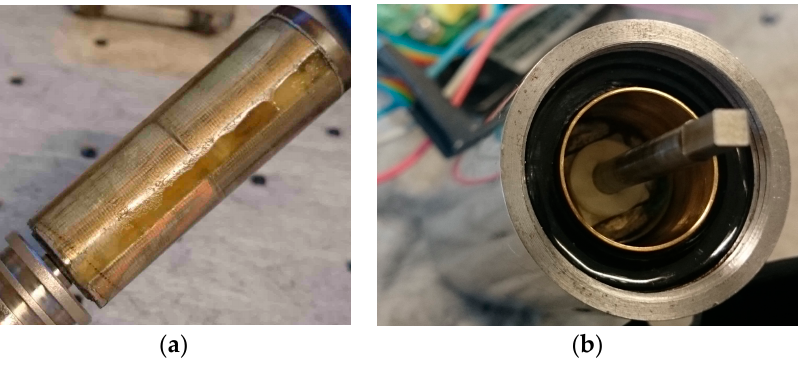
Figure 8. ( a ) Magnet rotor; ( b ) magnet stator and sleeve.